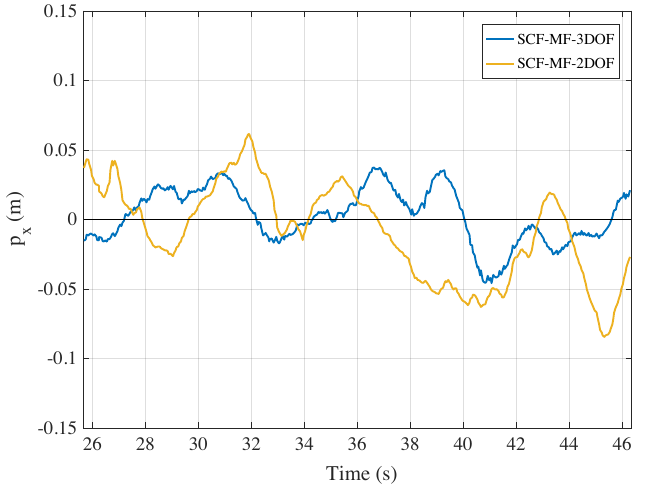
Figure 15. Comparison between the algorithms SCF-MF-2DOF (with 2-DOF gimbal) and SCF-MF- 3DOF that uses a 3-DOF gimbal suspension for the stabilization of the yaw angle. In this case, the comparison is made between the estimates obtained along the horizontal axis x